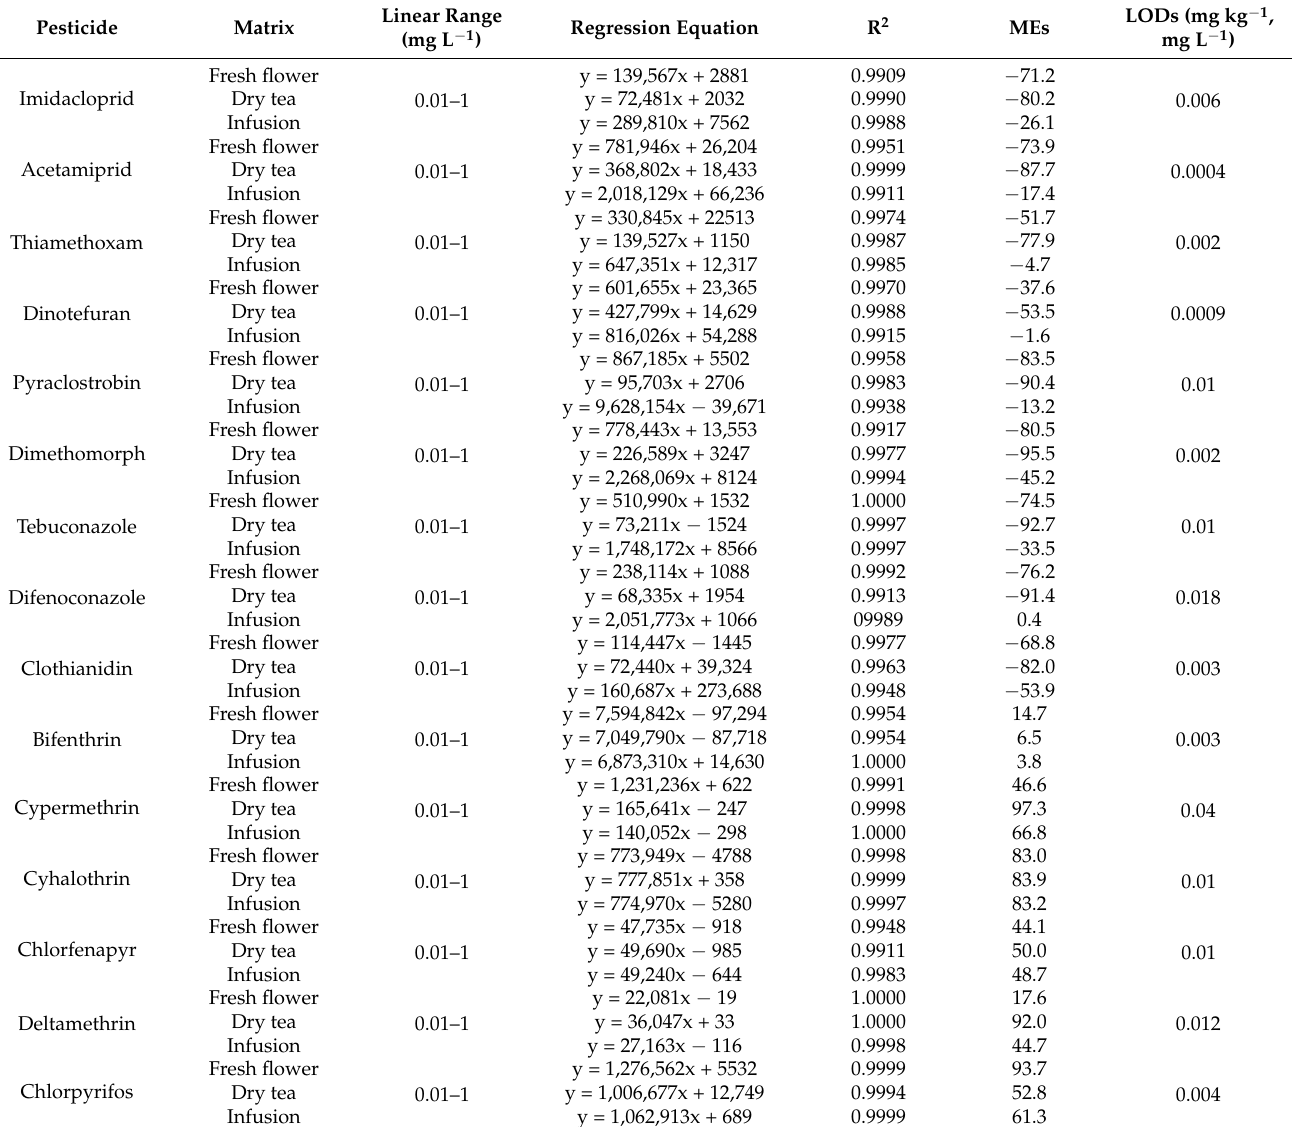
Table 2. The Linear range, Regression equations, Correlation coefficient (R 2 ), Matrix effects (MEs) and Limits of detection (LODs) of the 15 pesticides in different chrysanthemum